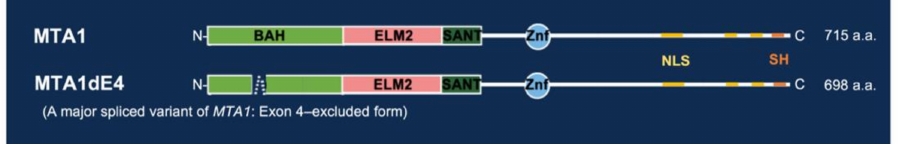
Figure 3. Schematic representation of structural domains of MTA1 and its exon 4-excluded form, MTA1dE4. NLS, nuclear localization signal; SH, src-homology binding